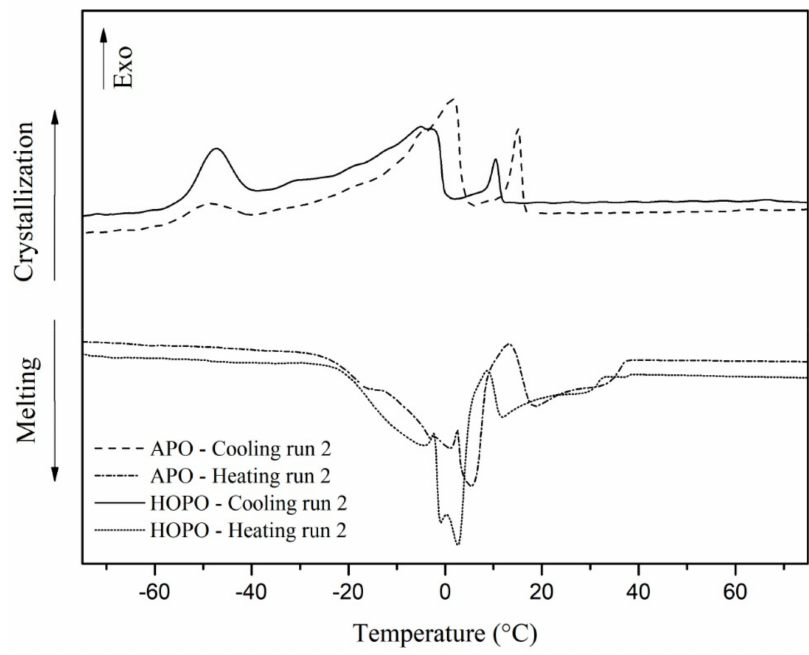
Figure 2. DSC curves in a heating and cooling program of APO and HOPO for run